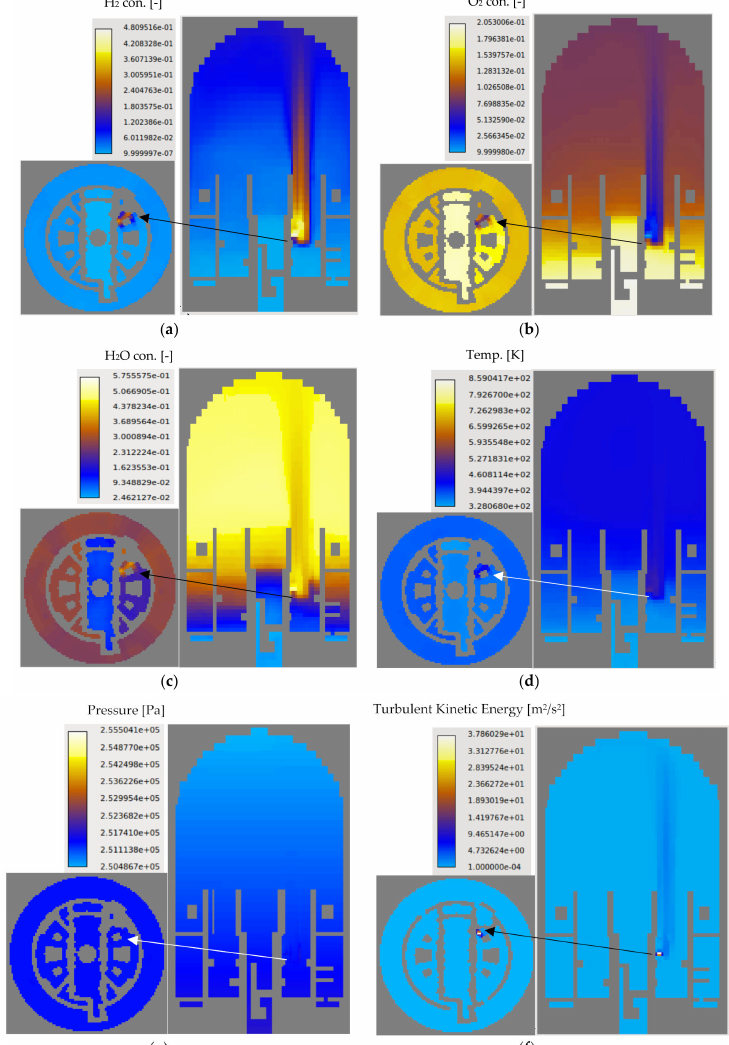
Figure 8. Initial Conditions of the COM3D Calculation for the Severe Accident. ( a ) Hydrogen Concentration; ( b ) Oxygen Concentration; ( c ) Steam Concentration; ( d ) Temperature; ( e ) Pressure; and ( f ) Turbulent Kinetic